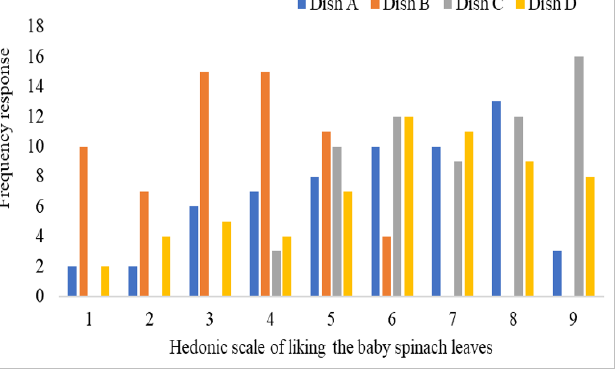
Figure 1 . Overall sensory rating on the baby spinach leaves grown under different fertilizer sources Dish A= goat manure, Dish B = Inorganic (7% N, 14% P, 7% K), Dish C = Poultry manure and Dish D = cattle manure